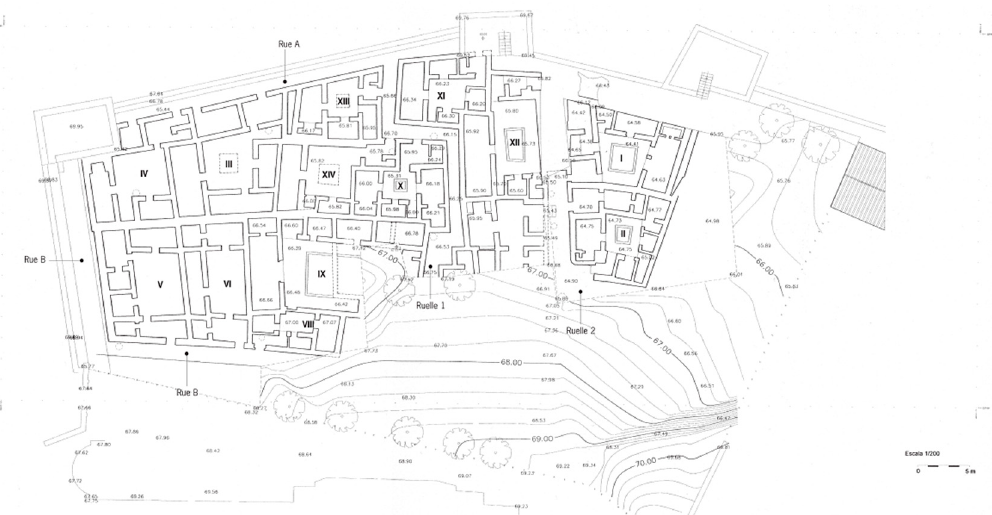
Figure 3. Mértola—Islamic quarter plan. Plan by the author.